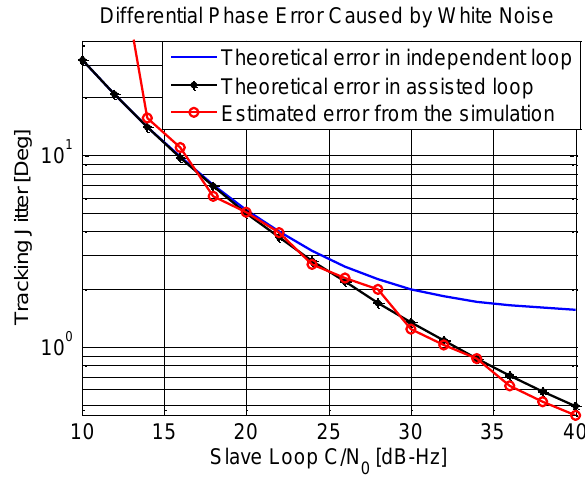
Figure 12. Phase jitter of differential phase output induced by thermal